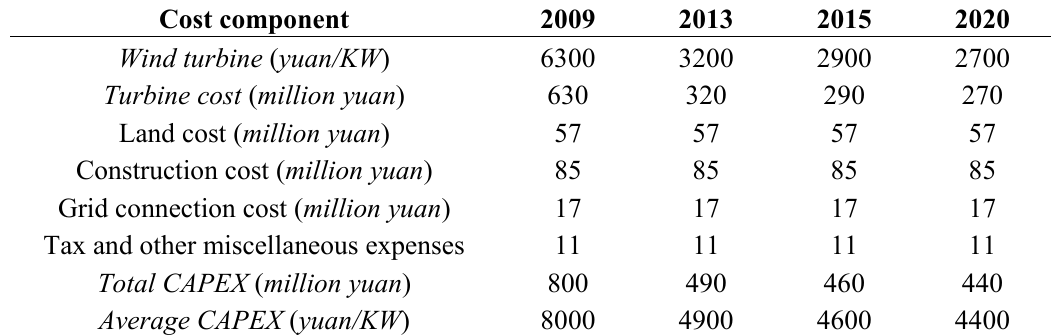
Table 1. The total investment of a 100-MW wind farm in China commissioned at various